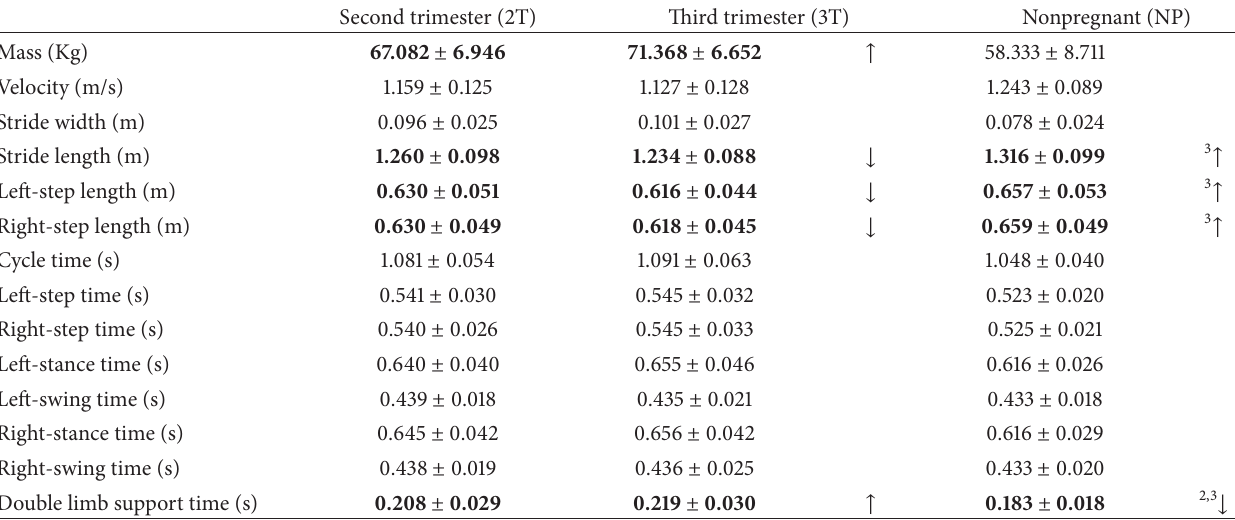
Table 1: Spatiotemporal parameters of gait during the later stages of the second and third trimesters of pregnancy ( 𝑁 = 22 ) and nulliparous controls ( 𝑁 = 22 ). Units (mean ± sd) of mass (Kg), velocity (m/s), length (m), and time (s).